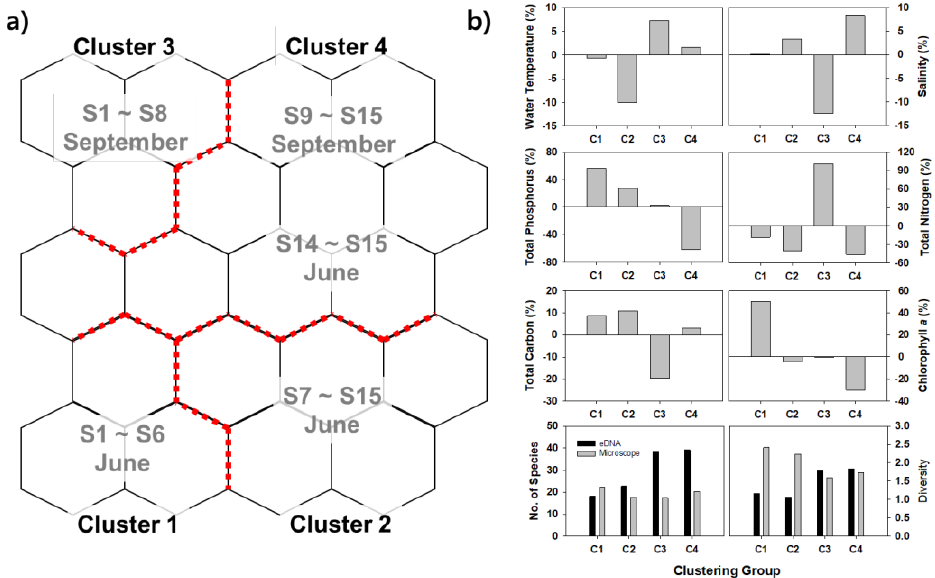
Figure 4. Clustering result ( a ) of the data of water eDNA and CMI based on the self-organizing map. The right panels ( b ) present the corresponding physical, chemical, and biological conditions in Gwangyang Bay. The horizontal lines of zero indicate corresponding grand average values (water temperature: 25.6 °C, salinity: 29.3 psu, TP: 0.049 mg L − 1 , TN: 0.45 mg L − 1 , TC: 22.4 mg L − 1 , Chl- a : 4.36 mg L − 1 ).